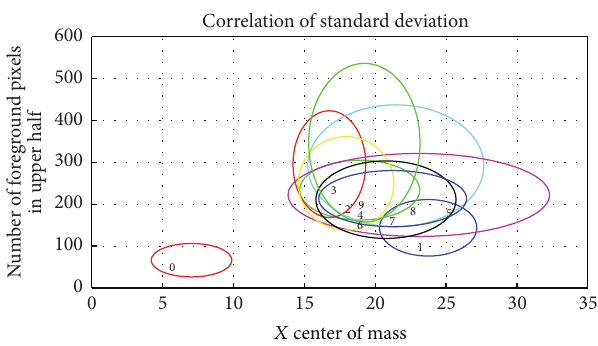
Figure 6: 2D SD spectrum distribution diagrams for Arabic/Farsi digits: “ 𝑋 Coordinate Centre of Mass” feature versus “Number of Foreground Pixels in Upper Half of Image” feature.